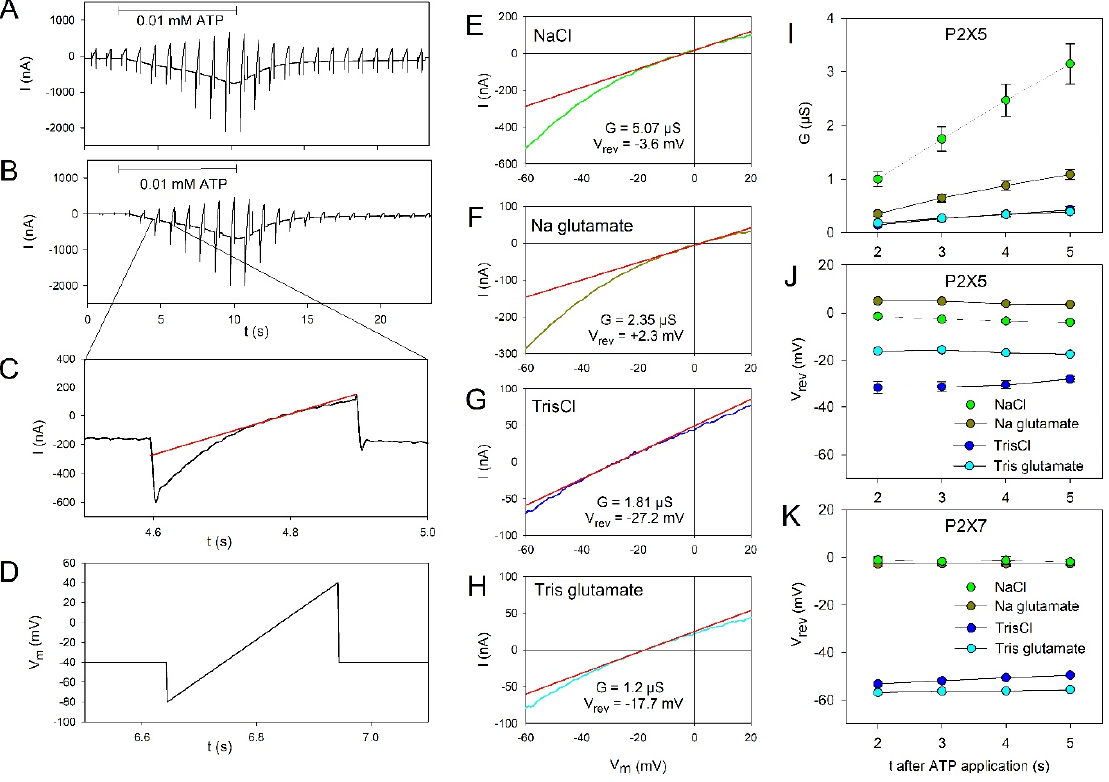
Figure 3. Permeation behavior of oocyte-expressed hP2X5 FL ion channels. Time course of ramp currents during voltage ramps applied every second before and during application of 0.01 mM ATP for the time indicated by the horizontal bar before ( A ) and after ( B ) subtraction of the resting ion currents. The bathing solution was a NaCl-based Ringer’s solution. ( C ) Current ramp from a section of B as indicated. The red straight line is the linear fit of the current around the reversal potential. ( D ) Voltage ramp protocol. ( E – H ) Examples of ramp currents induced by 0.01 mM ATP in bathing solutions with the indicated main extracellular ions. The ramp current recorded before the ATP application was subtracted. The red lines indicate the linear approximation of the current–voltage dependence near I = 0, from which the slope conductance G and the reversal potential V rev are obtained as indicated. Dependence of G ( I ) and V rev ( J , K ) on the extracellular ions of hP2X5 FL ( I , J ) and hP2X7 ( K ) expressing oocytes. All mean values are significantly different except the reversal potentials in NaCl and Na glutamate solution for hP2X7 expressing oocytes. Means from 13–37 oocytes.